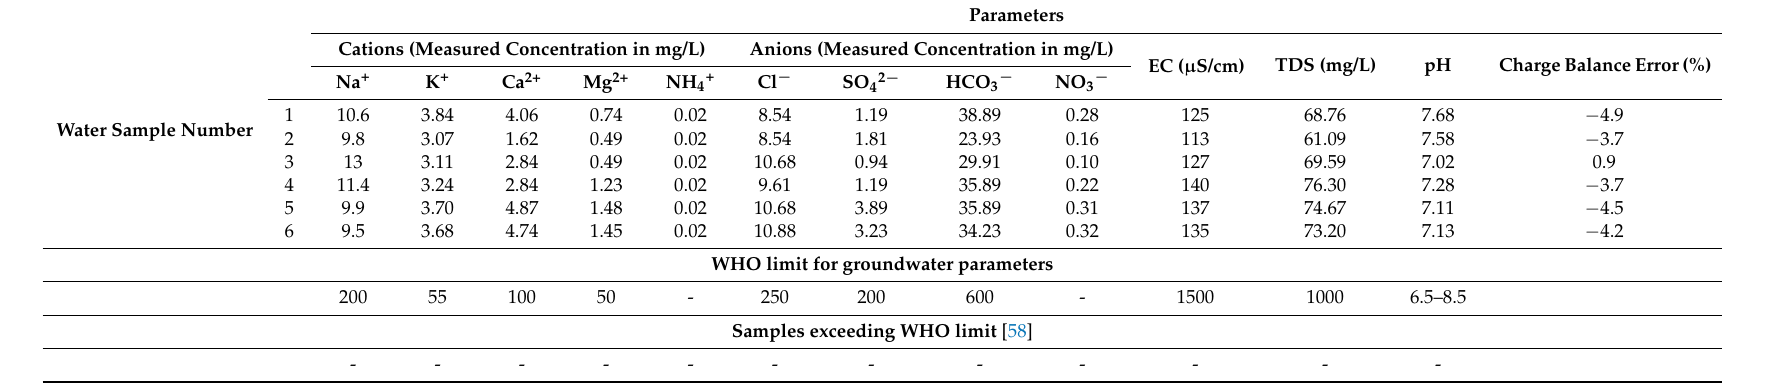
Table 3. The results of physicochemical analysis for groundwater